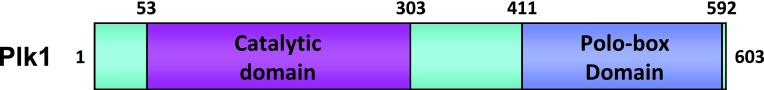
Schematic diagram of human polo-like kinase 1 (Plk1).The numbers indicate the positions of the amino acid residues in human Plk1.